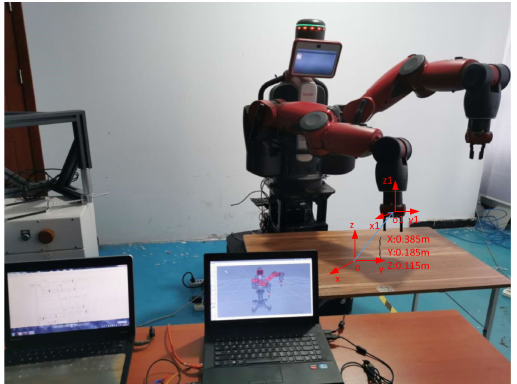
Figure 21. End effector displacements of Baxter’s right arm on the real